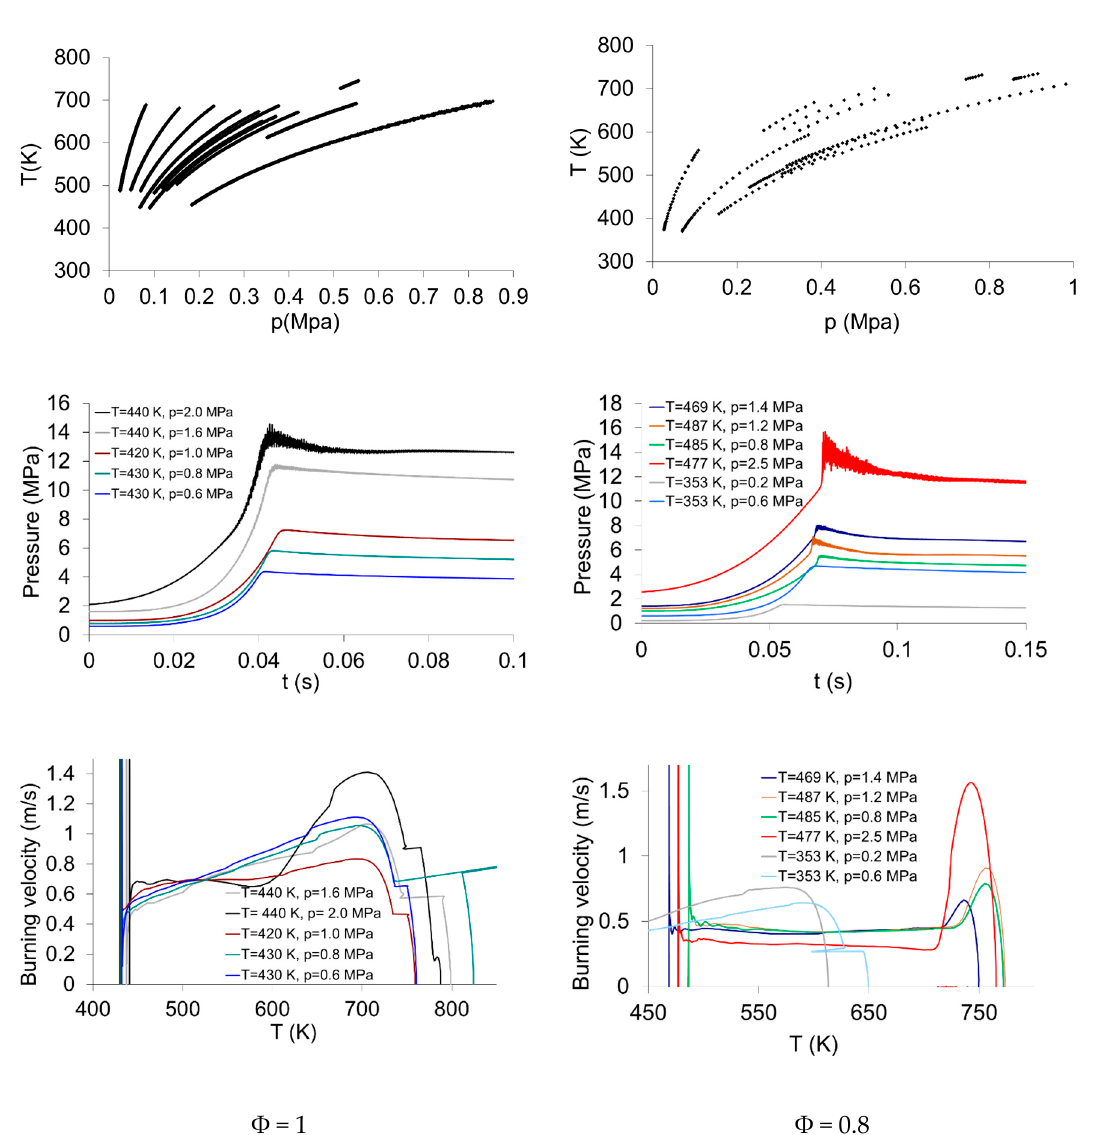
Figure 11. A temperature–pressure map, the temporal evolution of pressure and burning velocity versus temperature, for the mixture of 50% n-heptane / 50% toluene, for di ff erent initial conditions and equivalence ratios (1.0-left, 0.8-right).